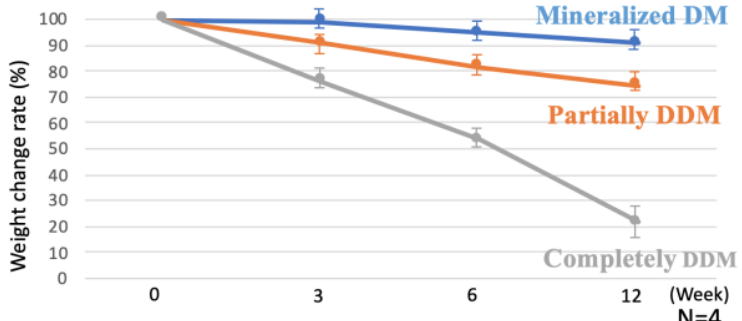
Figure 5. Dentin absorption by collagenase digestion. Weight change ratio of PDDM showing 91.2%, 82.4% and 74.5% at 3, 6 and 12 weeks after collagenase digestion. Weight-decreasing rate of CDM,